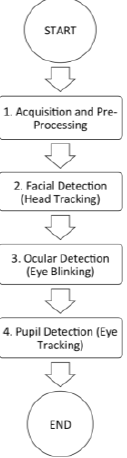
Figure 3. High-level block diagram.